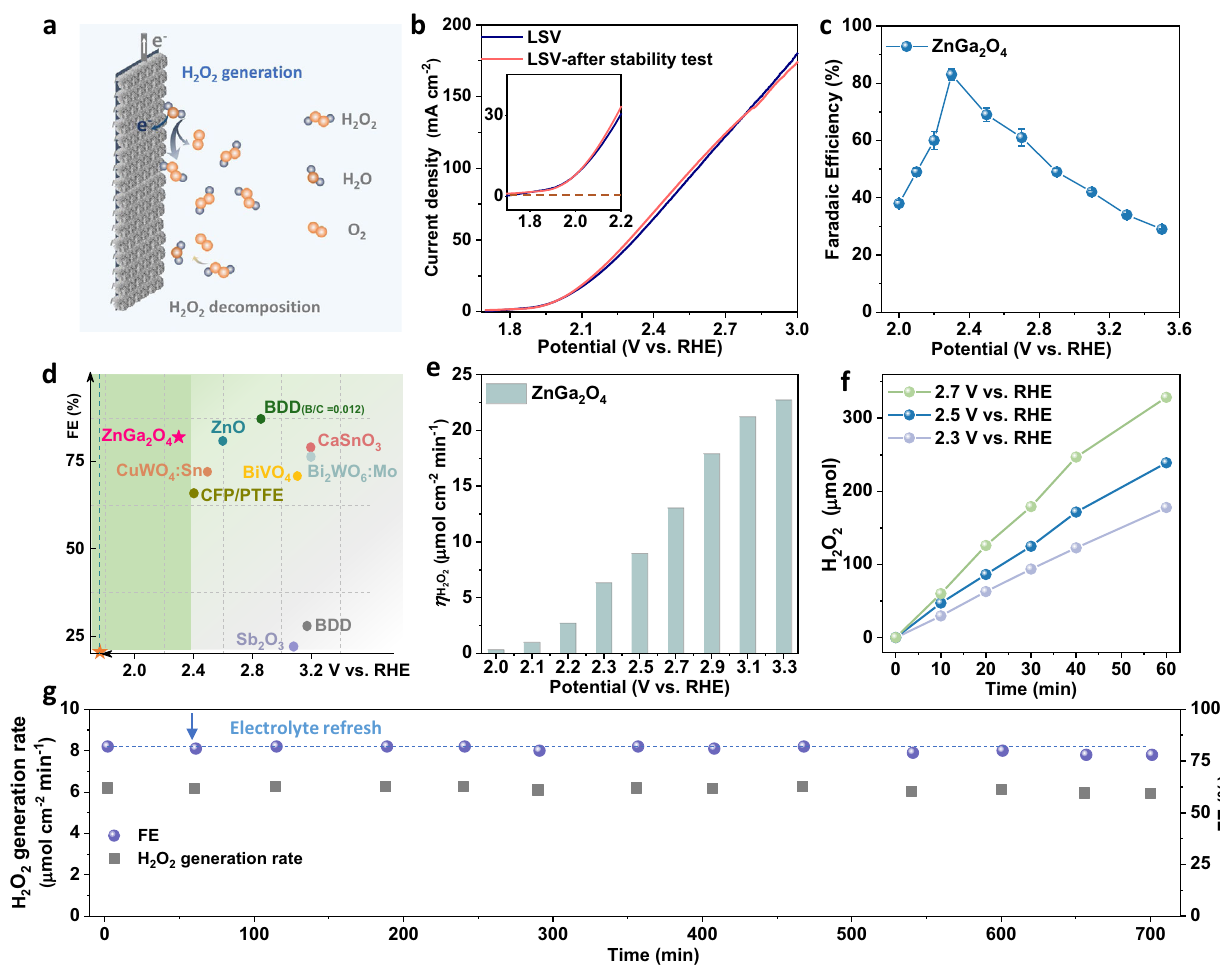
Fig.2|ActivityandstabilityofH 2 O 2 generationonZnGa 2 O 4 anode.a Schemeof the electrochemical H 2 O 2 production on anodes through a water oxidation reac- tion. b LSVcurvesrecordedin2MKHCO 3 beforeandafterastabilitytest.Thescan rate is 5mVs − 1 . c H 2 O 2 FE of the prepared ZnGa 2 O 4 anode at different potentials in 2M KHCO 3 electrolyte (Error bars represent the standard deviation of three inde- pendent measurements). d The FE of typically reported anodes including ZnO 25 , boron-doped diamond (BDD) 33 , BDD (B/D ratio = 0.012) 39 BiVO 4 38 , CaSnO 3 24 ,